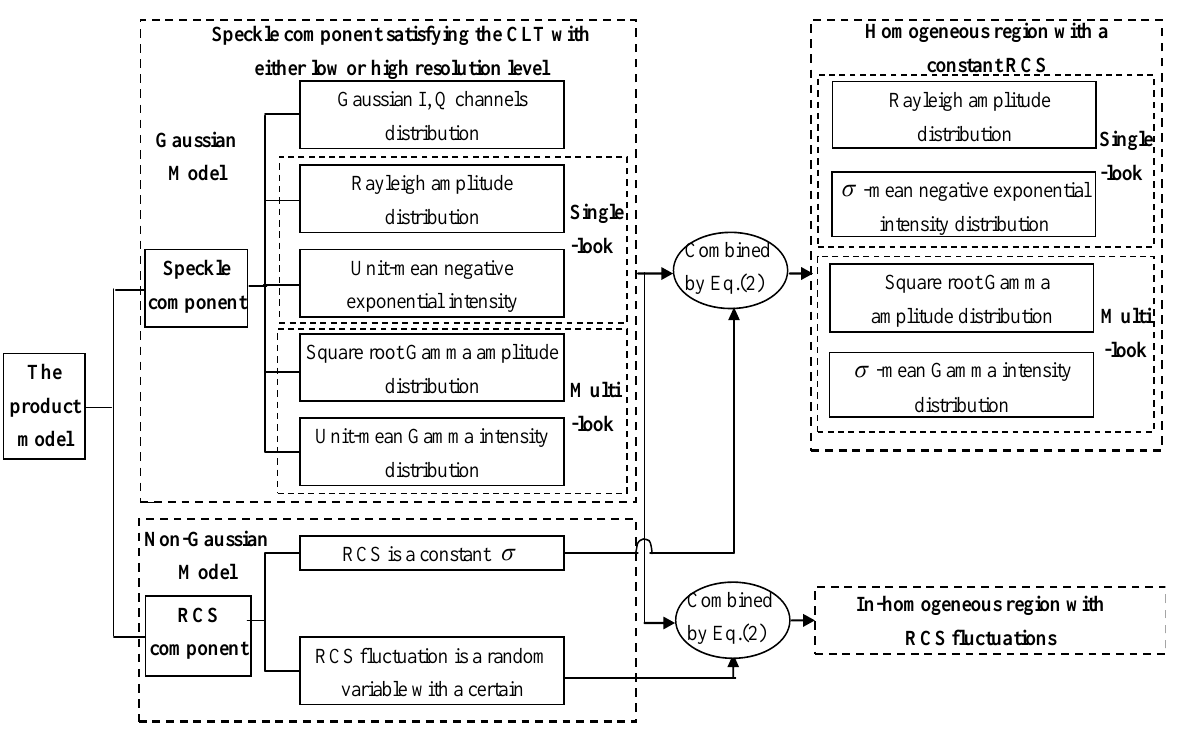
Figure 4. Statistical models of constant RCS or RCS fluctuations when the speckle component satisfy the central limit